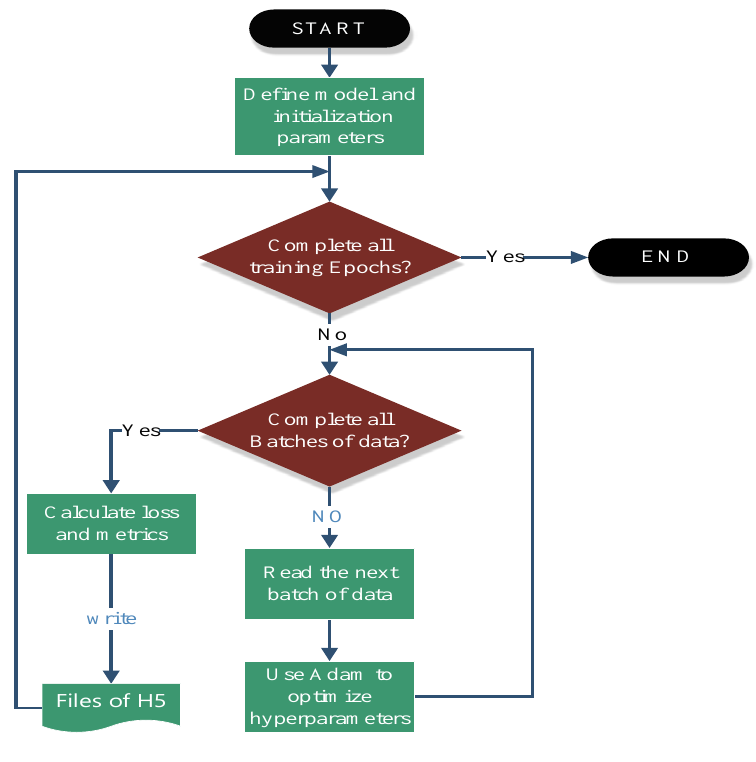
Figure 9. Workflow of training.